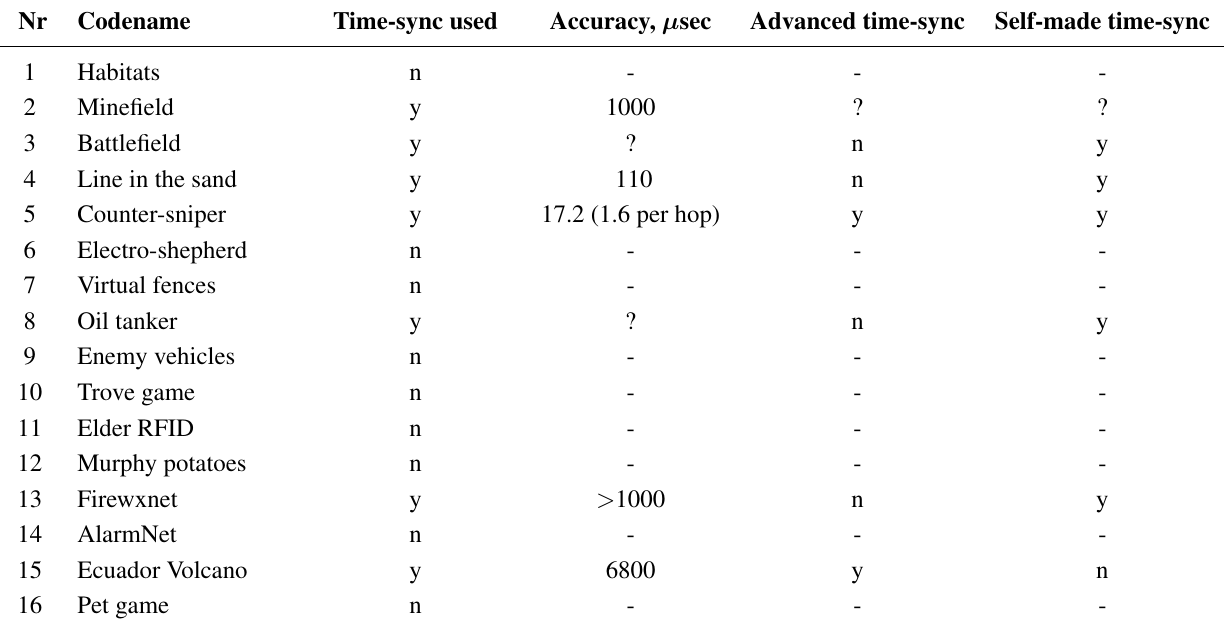
Table 16. Deployments: time